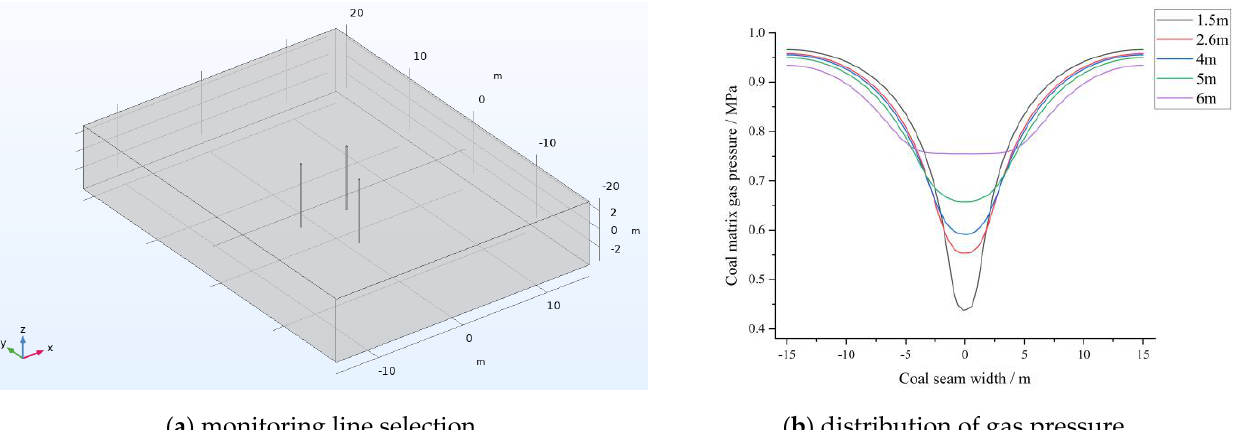
Figure 7. Gas pressure distribution of coal matrix on the cut-off line under different extraction spacing at 140 d.